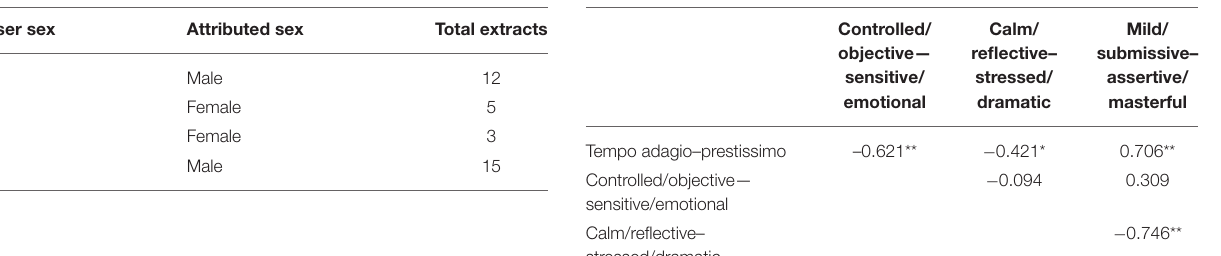
TABLE 1 | Directions of composer-sex attributions. TABLE 2 | Correlations between Music Characteristic